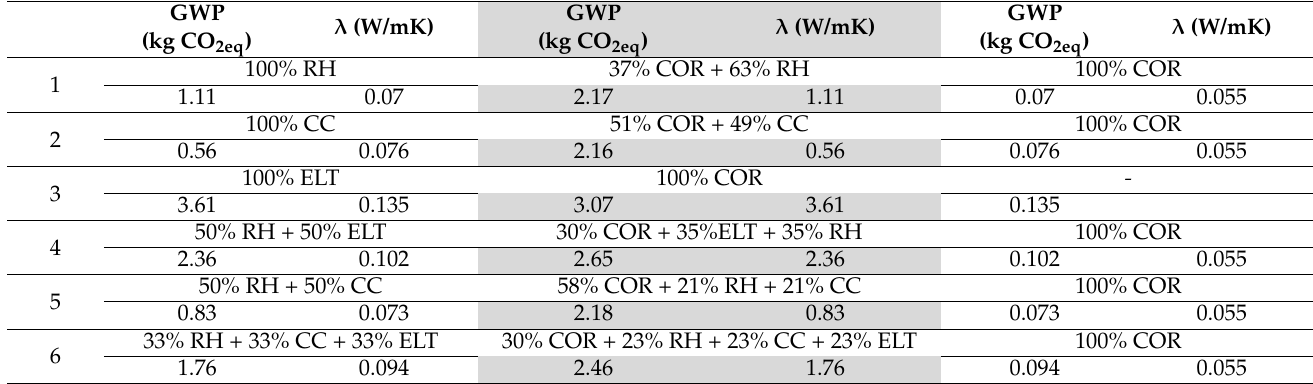
Table 8. Global Warming Potential and Thermal Conductivity values obtained for the best identified mixture (in the grey column the best mixing ratios are reported).